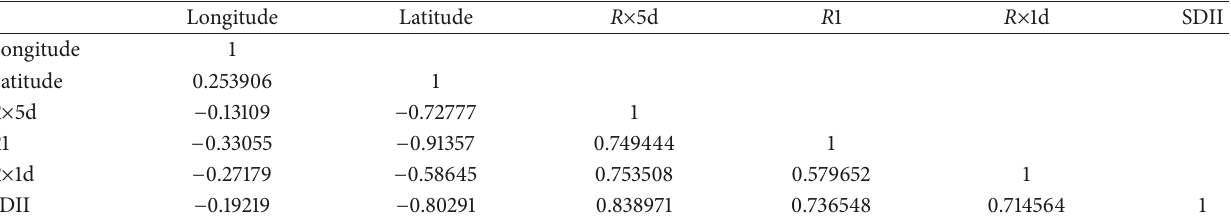
Table 4: Correlation matrix of the precipitation indices for the period 1985–2015 (significant at 5%